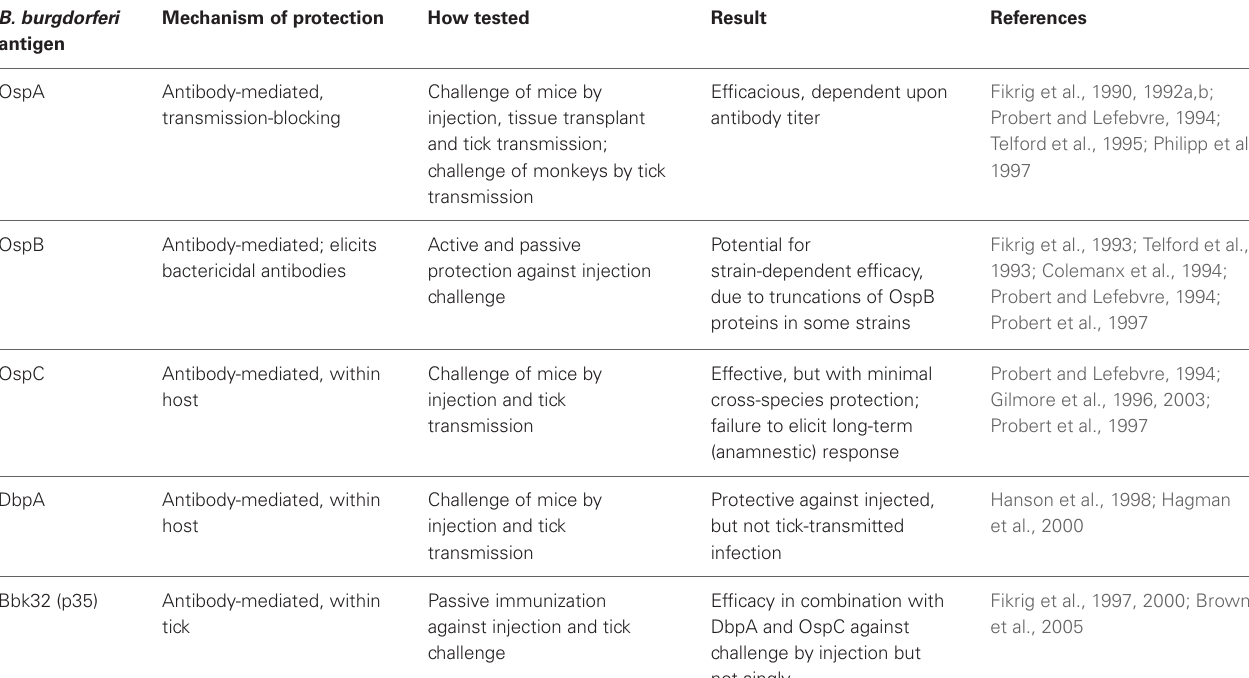
Table 1 | Prospective Lyme vaccine antigens from B.